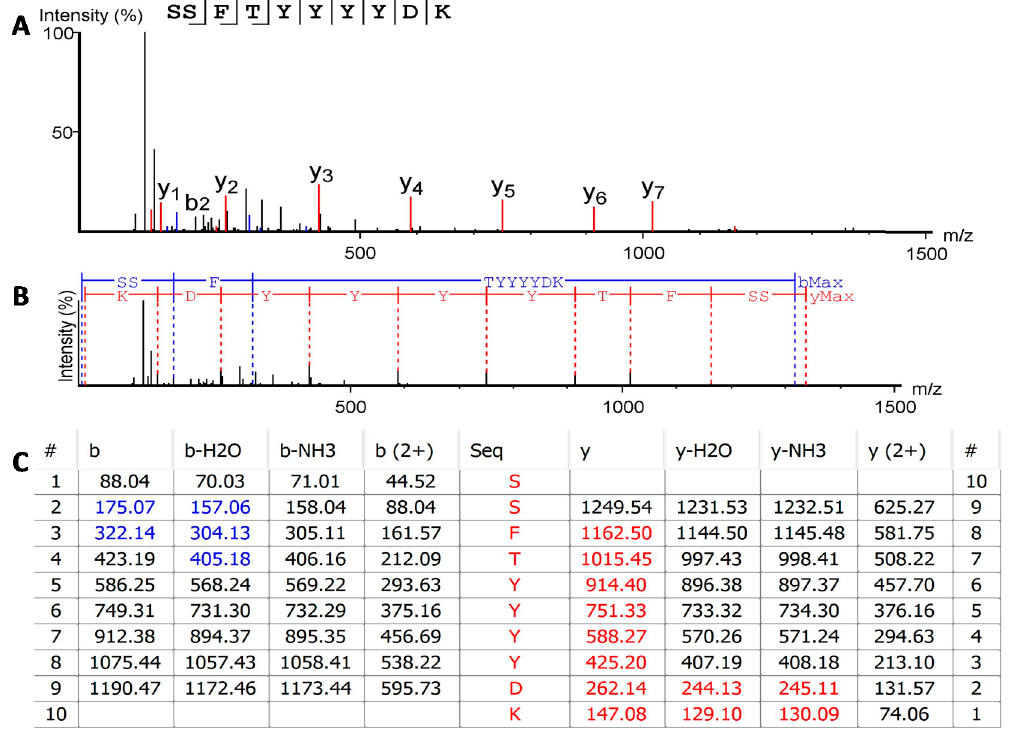
Figure 4. De novo sequence prediction of the most abundant trypsin-digested peptide from fraction c. ( A ) Annotated spectrum of peptide SSFTYYYDK showing identified b (blue signal) and y (red signal) ions. ( B ) Alignment of the spectrum with the fragment ions generated from the peptide, bMax: is the most intense peak in the spectrum corresponding to b ions series (blue uppercase letter and lines); yMax: is the most intense peak in the spectrum corresponding to y ions series (red uppercase letter and lines). ( C ) Predicted b and y ions match table with the calculated mass of possible fragment ions; spectrum matching b ions are highlighted in blue and spectrum matching y ions are highlighted in red, #: identifies the order of the ions identified in the spectrum according to each ion series.